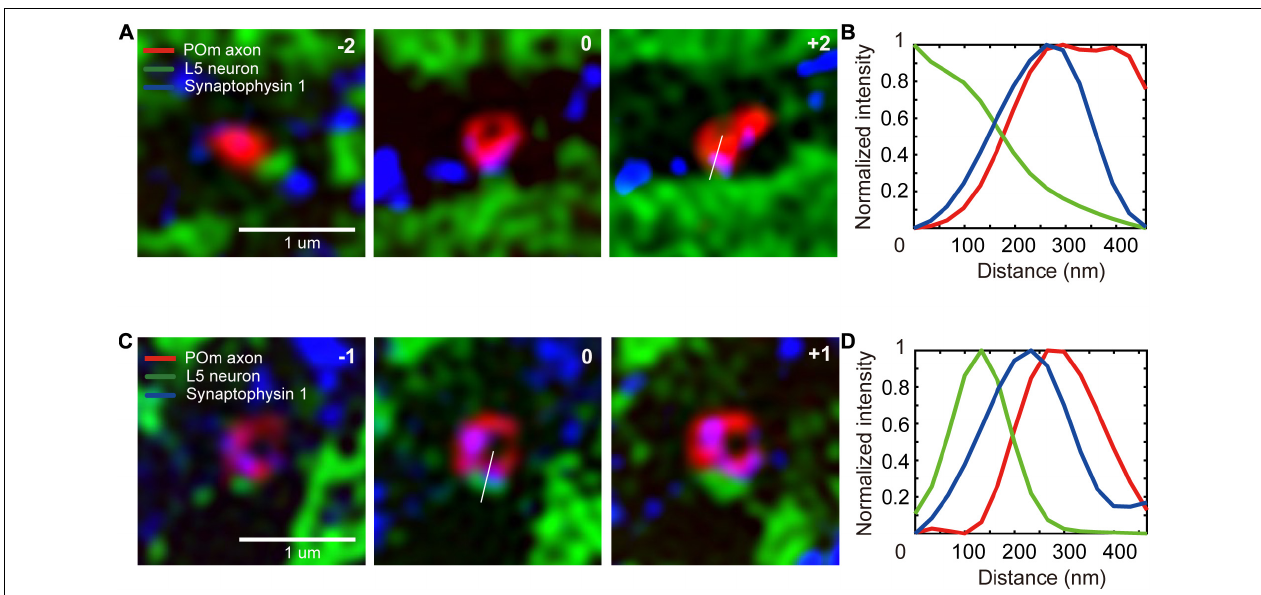
FIGURE 4 | Detection of the synapses-of-interest. (A,C) A series of SIM images of synapses-of-interest (scale bar = 1 µ m). The numbers at the top right-hand corner indicate the relative z location from the section in which a synapse was identified. (B,D) Signal intensity histogram of the three channels across the white lines shown in the